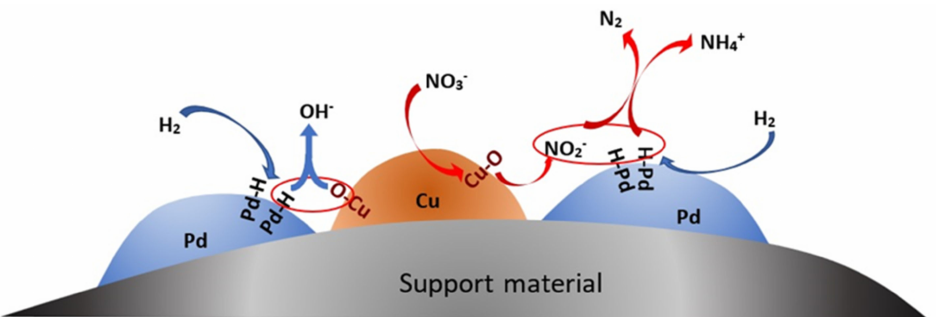
Figure 7. Scheme of the reactions taking place on the surface of a bimetallic